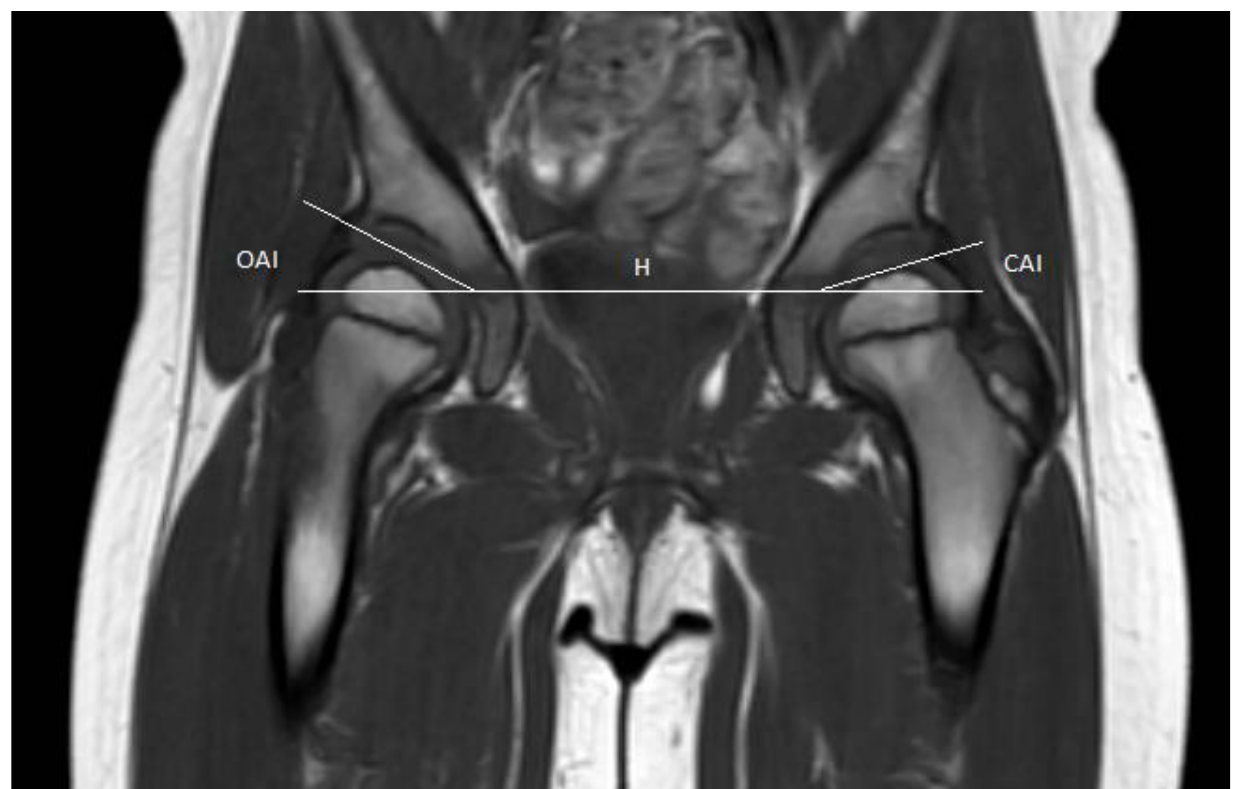
Figure 1. T1 weighted coronal magnetic resonance image scan of a paediatric pelvis. H: Hilgenreiner’s line; OAI: Osseous acetabular index; CAI: cartilaginous acetabular index. CAI was measured as the angle between Hilgenreiner’s line and a line drawn from the lateral margin of the cartilaginous acetabulum at the attachment of the labrum to the superolateral margin of the triradiate cartilage.